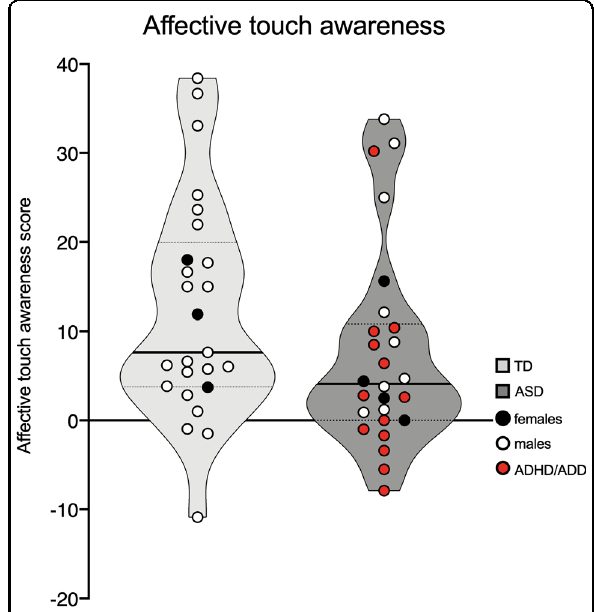
Fig. 2 Affective touch awareness scores. Individuals with ASD ( N = 26) had marginally lower scores compared to TD ( N = 25) ( p = 0.08).